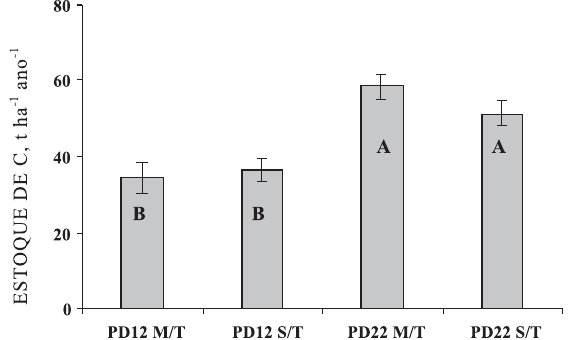
Figura 1. Estoque de C no solo (t ha -1 ) corrigido pela massa de solo amostrada para a camada de 0,00– 0,200 m sob SPD com 12 e 22 anos de implantação nas sucessões milho/trigo (M/T) e soja/trigo (S/ T), no município de Tibagi (PR). Os resultados representam a média (n = 12) ± desvio-padrão. pelo teste de Tukey (p <